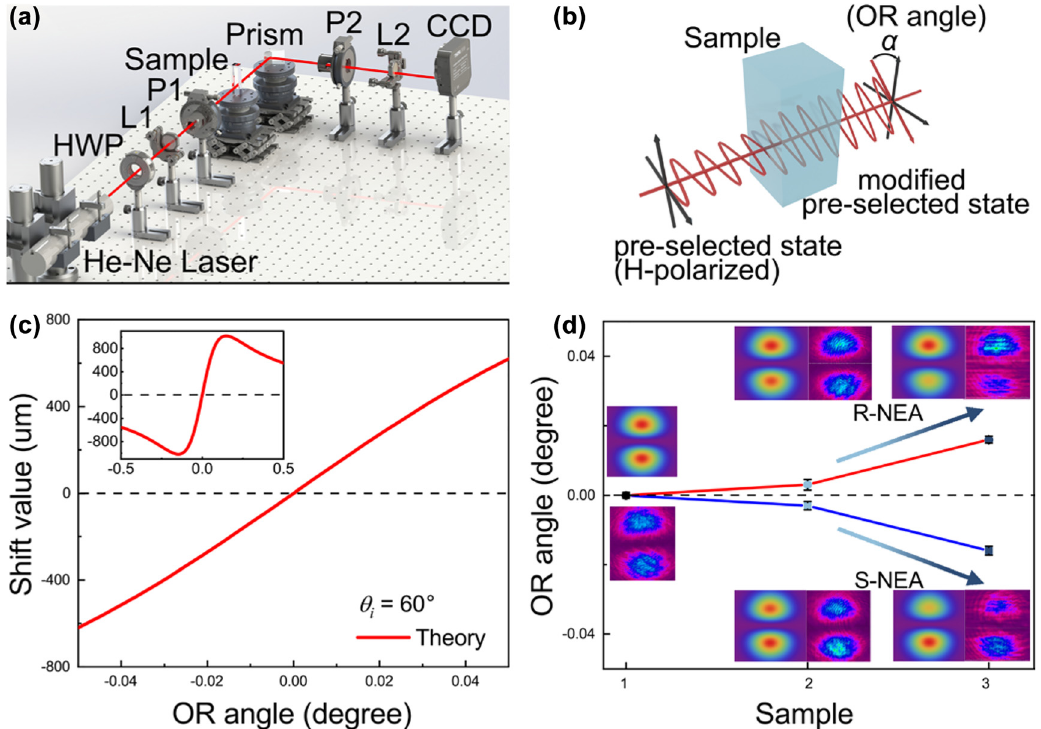
Figure 2: The experimental demonstration in photonic SHE. (a) Experimental scheme for the weak measurement system of photonic SHE; (b) schematic diagram of OR angle provided by chirality concerning the plane of polarization of incident light; (c) theoretical relationship between OR angle and amplified transverse shift of photonic SHE in the weak measurement system; (d) the observation results of OR angle NCs, 2: NEA ligands, and 3: NEA-coated FAPbBr NCs) derived by amplified transverse shift; the insert of sample (1: non–NEA-coated FAPbBr 3 3 shows light spot splitting of the photonic SHE in theory and